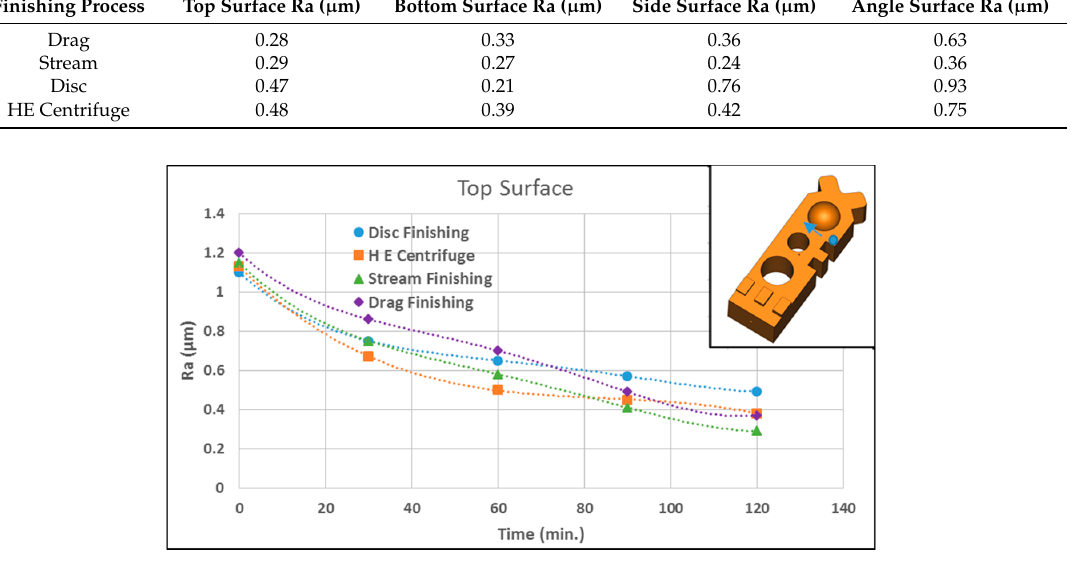
Figure 8. Surface roughness comparison on bottom surface (blue arrows show direction of measurement).